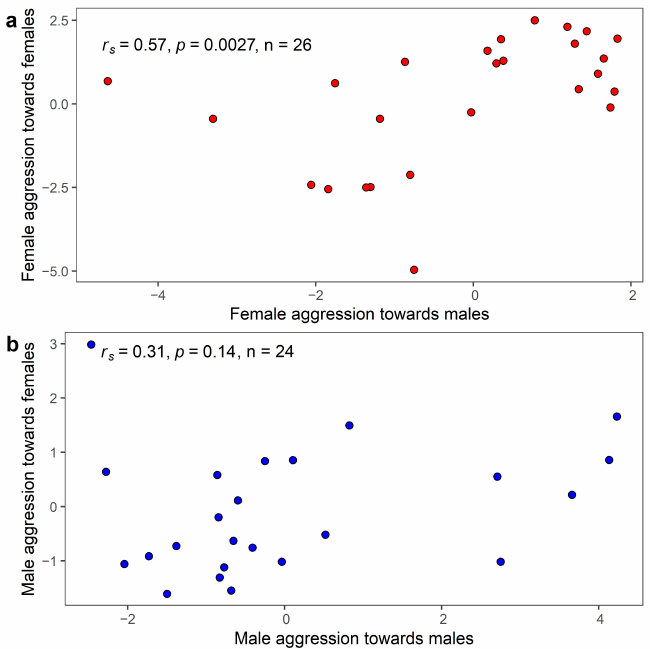
Figure 3. Scatterplot showing the individual consistency between intra-sexual and inter-sexual aggression based on PC1 for each sex (N Female = 26; N Male = 24). ( a ) Female aggression towards females versus female aggression towards males; ( b ) Male aggression towards females versus male aggression towards males. The Spearman correlation coefficient and p -value are presented in the top left